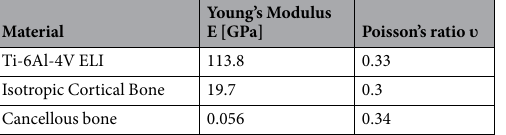
Table 1. Elastic mechanical properties of materials used in the FE model 17, 19, 31, 32